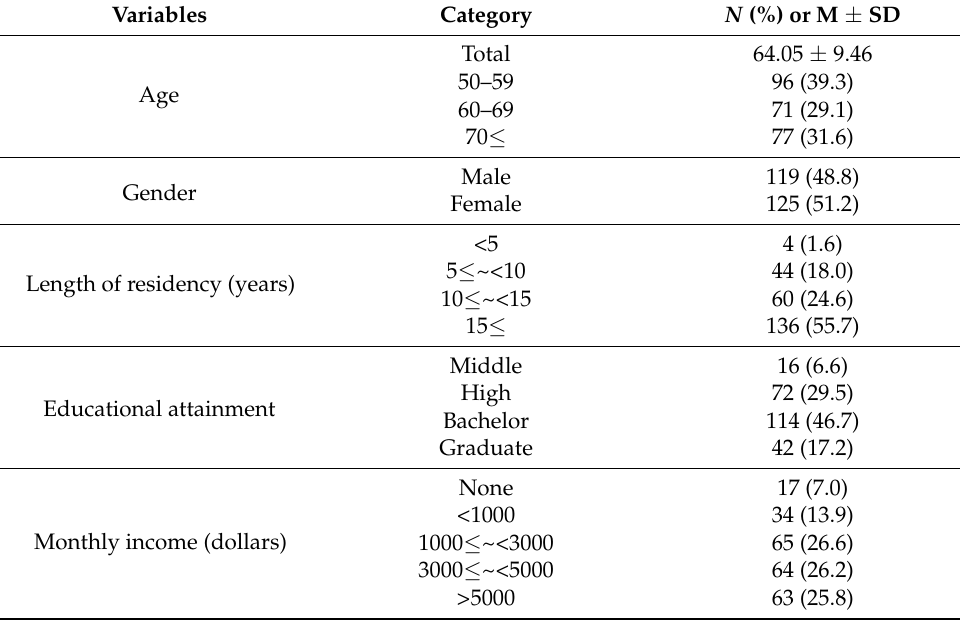
Table 1. Characteristics of the participants ( N =